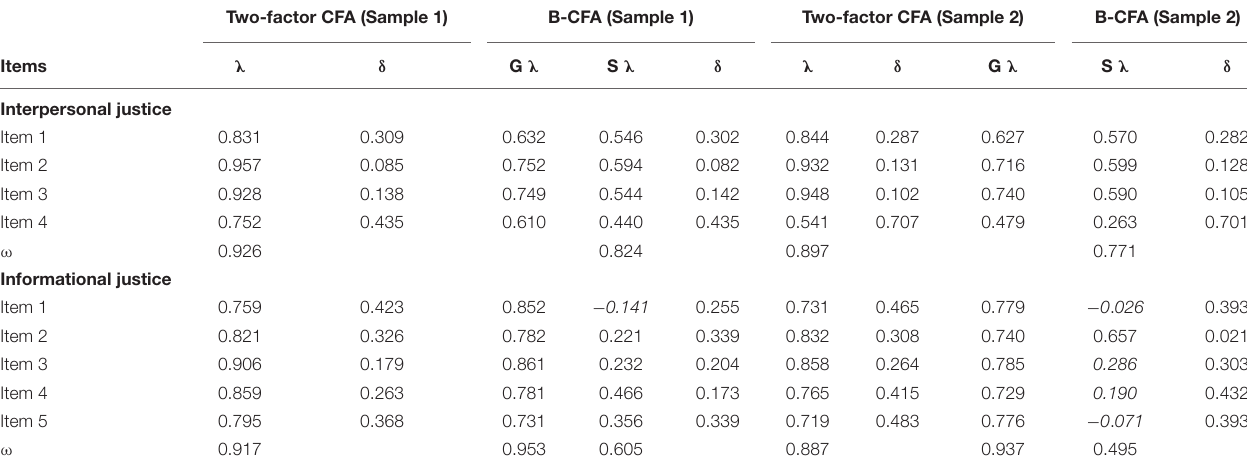
TABLE 2 | Standardized factor loadings ( λ ) and uniquenesses ( δ ) for the measurement models (Study 1).